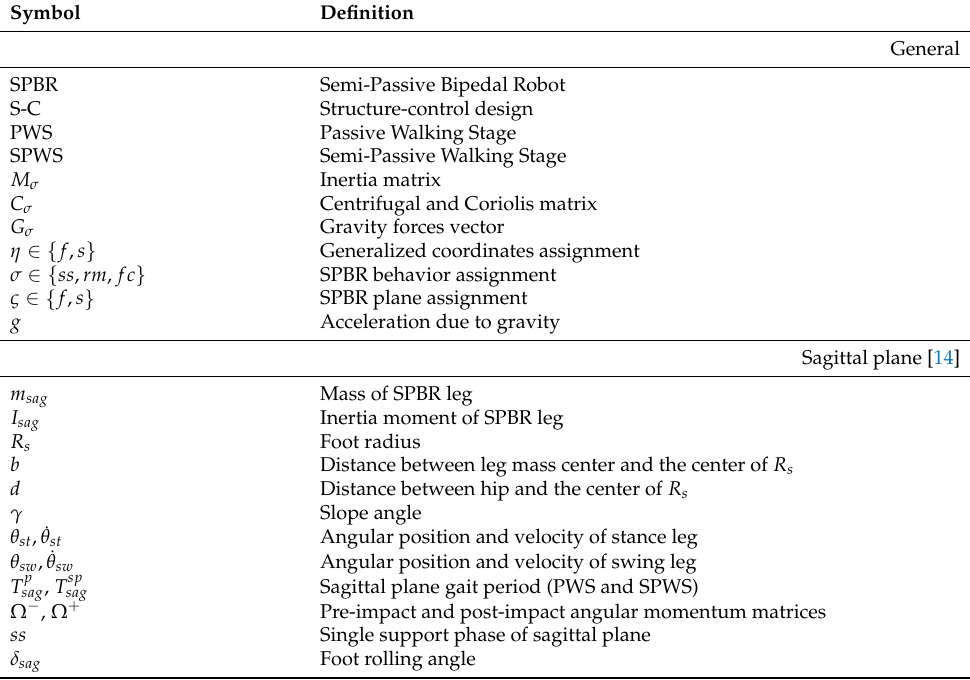
Table A1. SPBR dynamic model